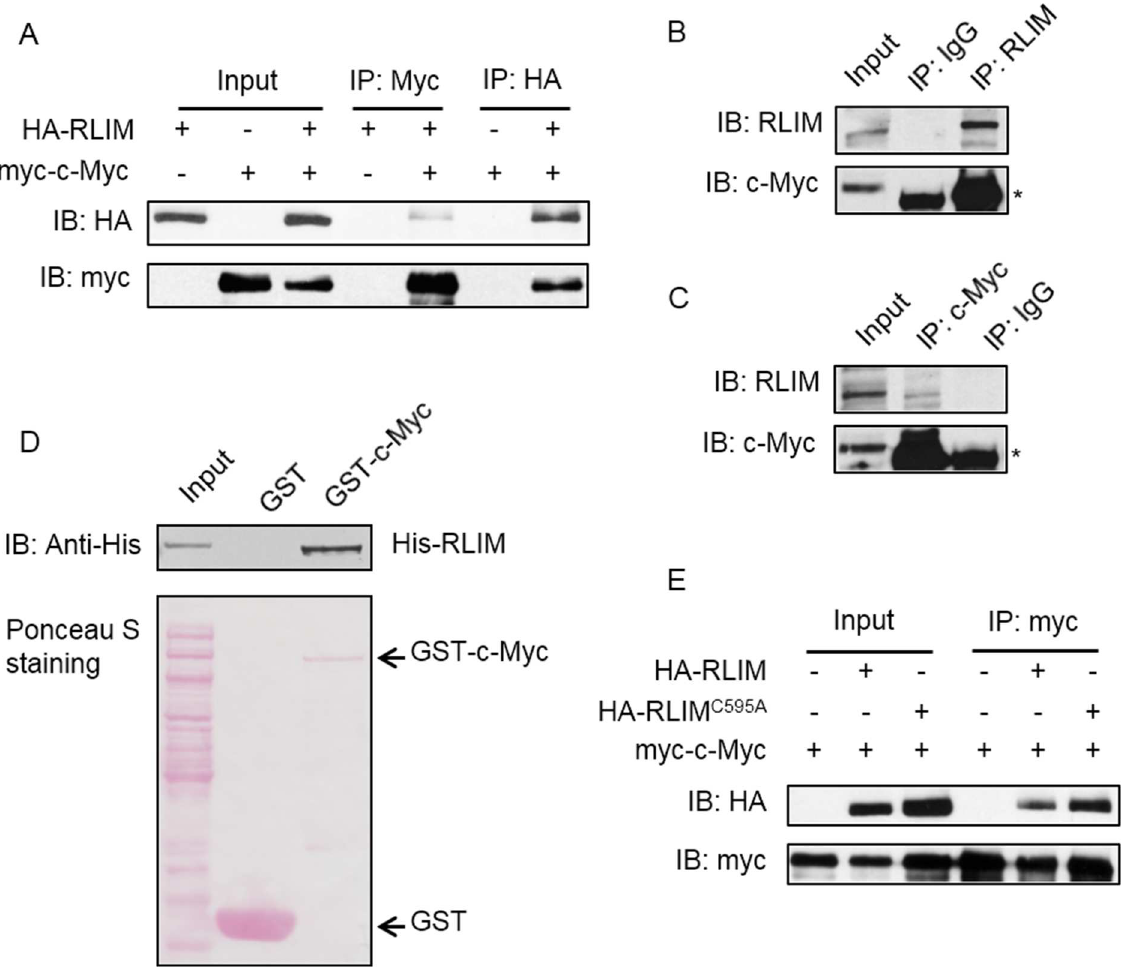
Fig 1. RLIM interacts with c-Myc. (A) 293T cells were transfected with HA-RLIM and myc-c-Myc expression vectors and immunoprecipitation was carried out with anti-myc or anti-HA antibodies as indicated.Immunoprecipitates were subjected to WB with anti-HA and anti-myc antibodies.(B) and (C) 293T cell lysate was subjected to immunoprecipitation with control IgG antibody and anti-RLIM (B) or anti-c-Myc (C) antibodies.Immunoprecipitates were subjectedto WB with anti-c-Myc and anti-RLIM antibodies. * indicatesthe heavy chain of IgG. (D) Purified bacterial-expressed GST or GST-c-Myc proteins were incubatedwith bacterial-expressed His-RLIM protein. Interaction between RLIM and c-Myc were detected by GST pull-downand subsequent WB with anti-His antibody. (E) 293T cells were transfected with WT or catalytic dead HA-RLIM together with myc-c-Myc. Cells were subjected to immunoprecipitation with anti-myc antibody followedby WB with anti-HA and anti-myc